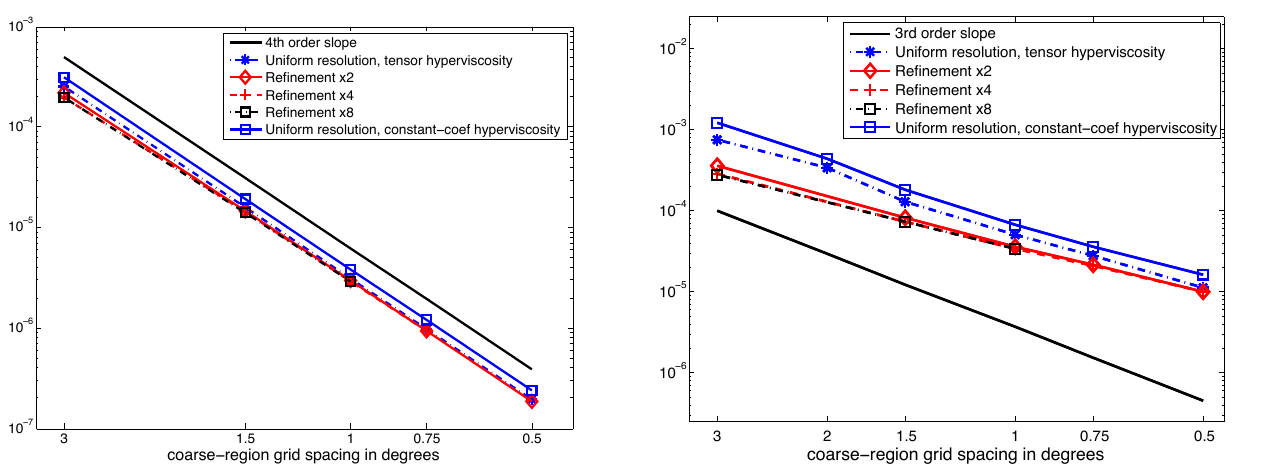
Figure 12. As in Fig. 11, except for TC5. In case of tensor-based hyperviscosity, three error curves for grid refinement with × 2, × 4 or × 8 local refinement are practically indistinguishable and obtain the same convergence rates as seen with uniform grids. For a given (cid:49)x low , the presence of some local refinement ( × 2) does decrease the global error, but × 4 or × 8 levels of local refinement produce no further